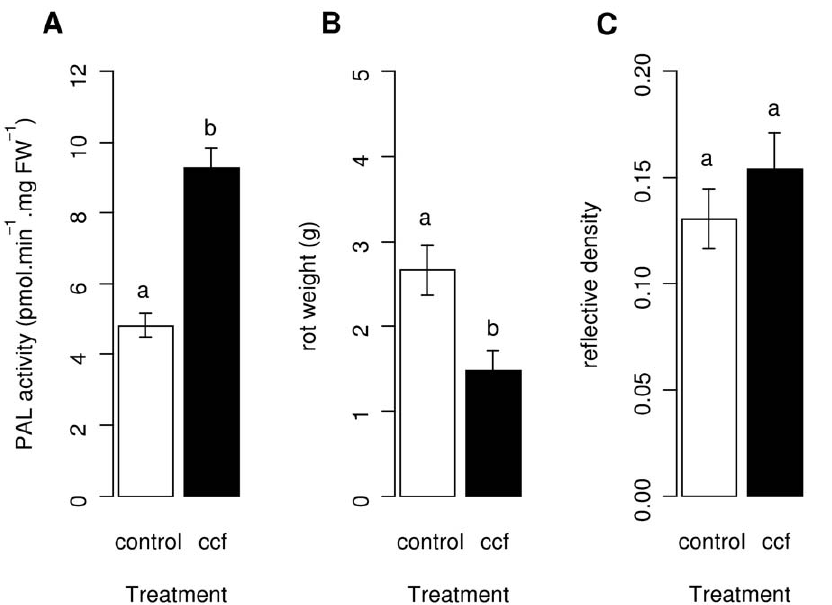
Figure 4. Phenylalanine ammonia-lyase activity and disease severity in potato tubers pre-treated with CCF. Tuber slices of cultivar Bintje were surface-treated with 100 m l of a concentrated culture filtrate (CCF) of Phytophthora infestans at a concentration of 400 m g.ml 2 1 or with water as the control. Slices were incubated during 7.5 h at 20 u C and subsequently assayed for Phenylalanine ammonia-lyase (PAL) activity (A) or inoculated with pathogens. For Pectobacterium atrosepticum (B), weight of soft rot developed during 5 days at 20 u C was measured. For P. infestans (C), disease developed during 5 days at 17 u C and is expressed as reflective density. PAL activity was determined in four aliquot samples prepared form pooled tissue of 5 tuber slices and disease severity was determined in 10 tuber slices. Bars correspond to means 6 standard error of data from two replicate experiments. Different letters above bars indicate significant differences between means of treatments (Tukey’s test, p , 0.05).